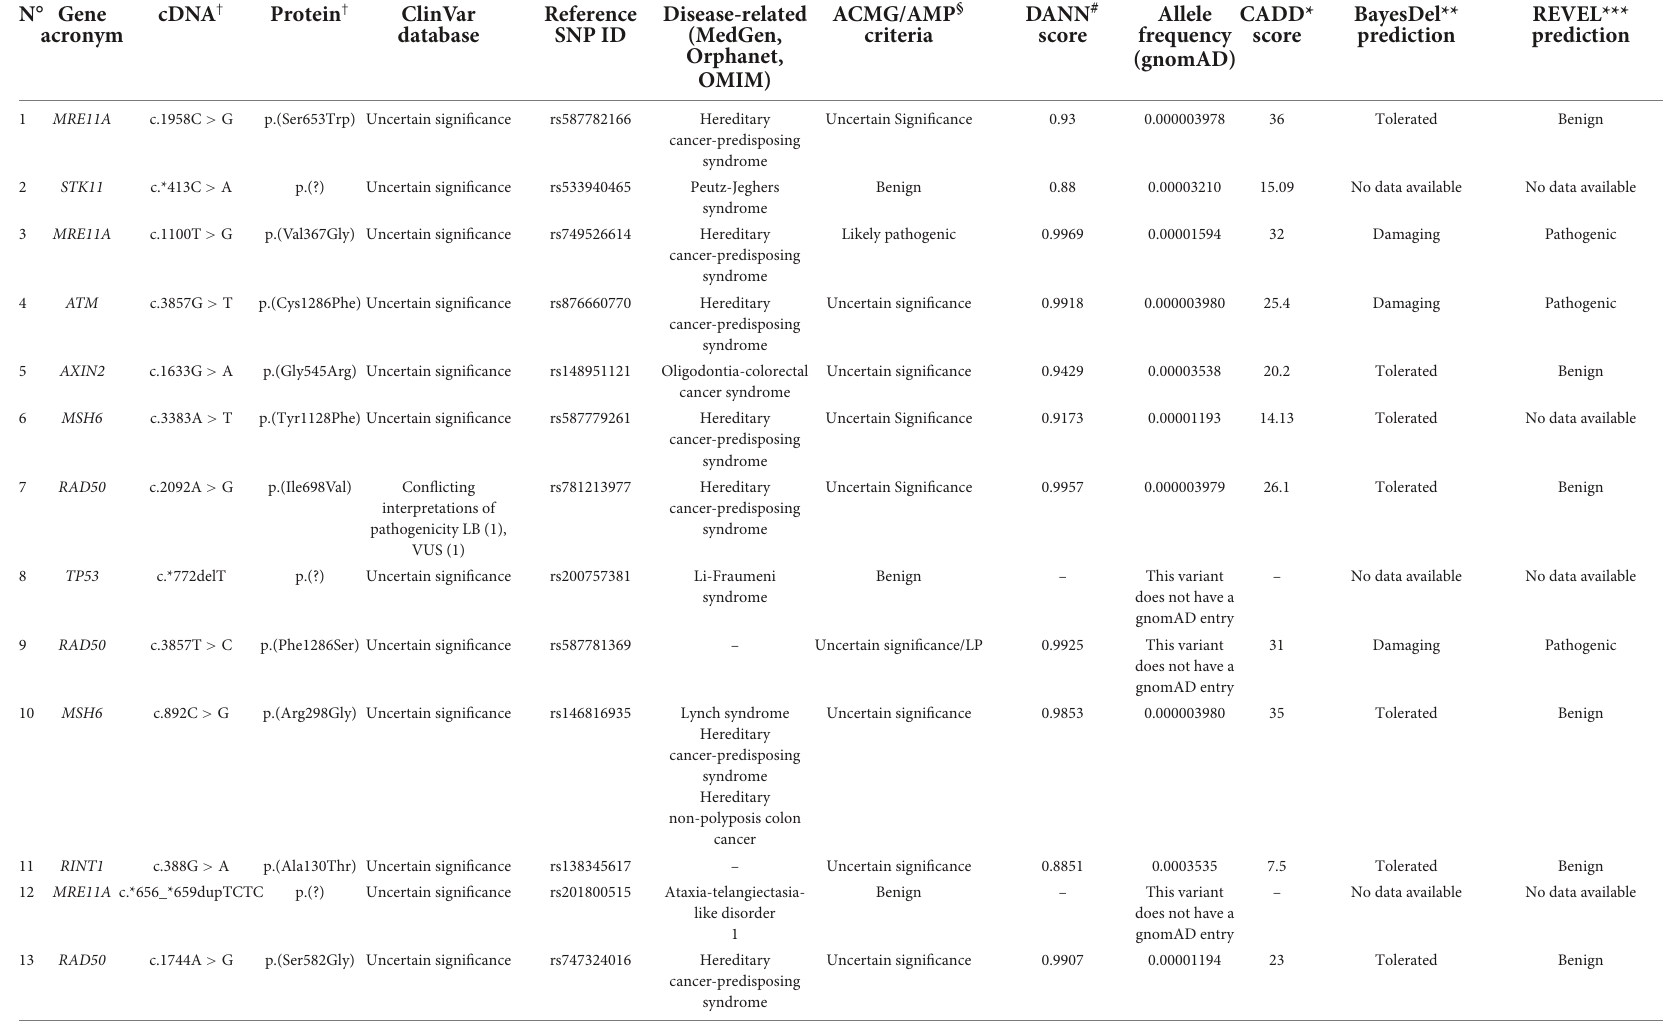
TABLE 4 List of the 33 variants of unknown significance (VUSs) identified in 23 patients (36%). N ◦ Gene